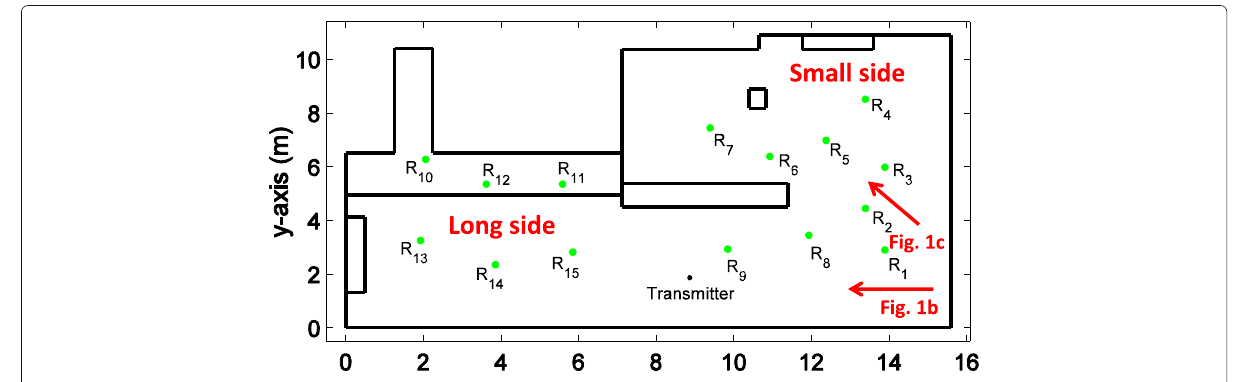
Fig. 10 Measurement environment: schematic representation